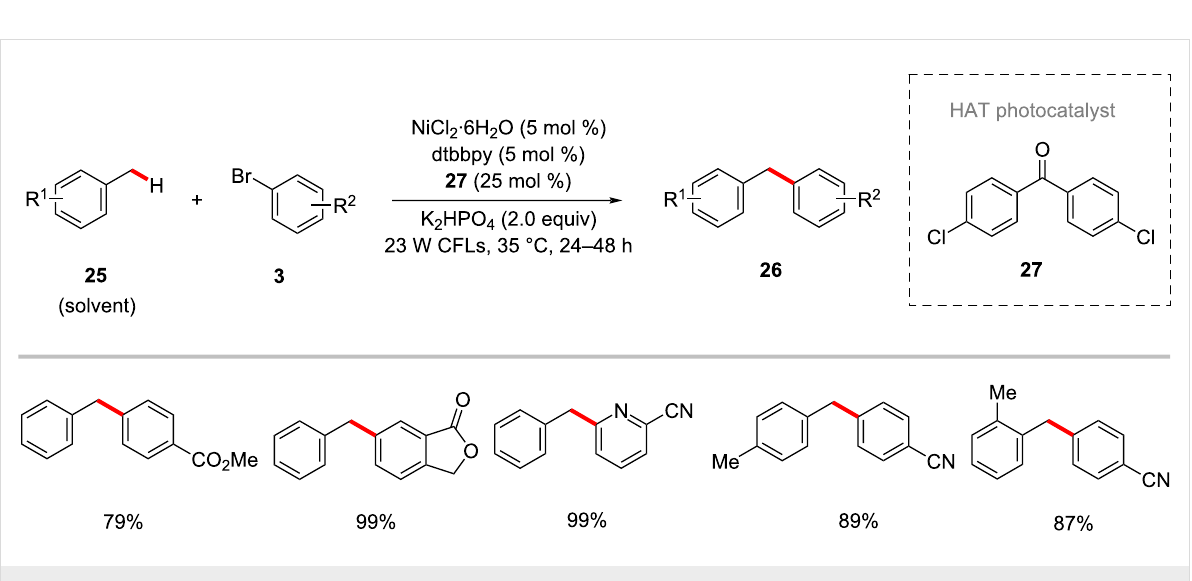
Scheme 15: Benzophenone- and nickel-catalyzed photoredox benzylic C–H